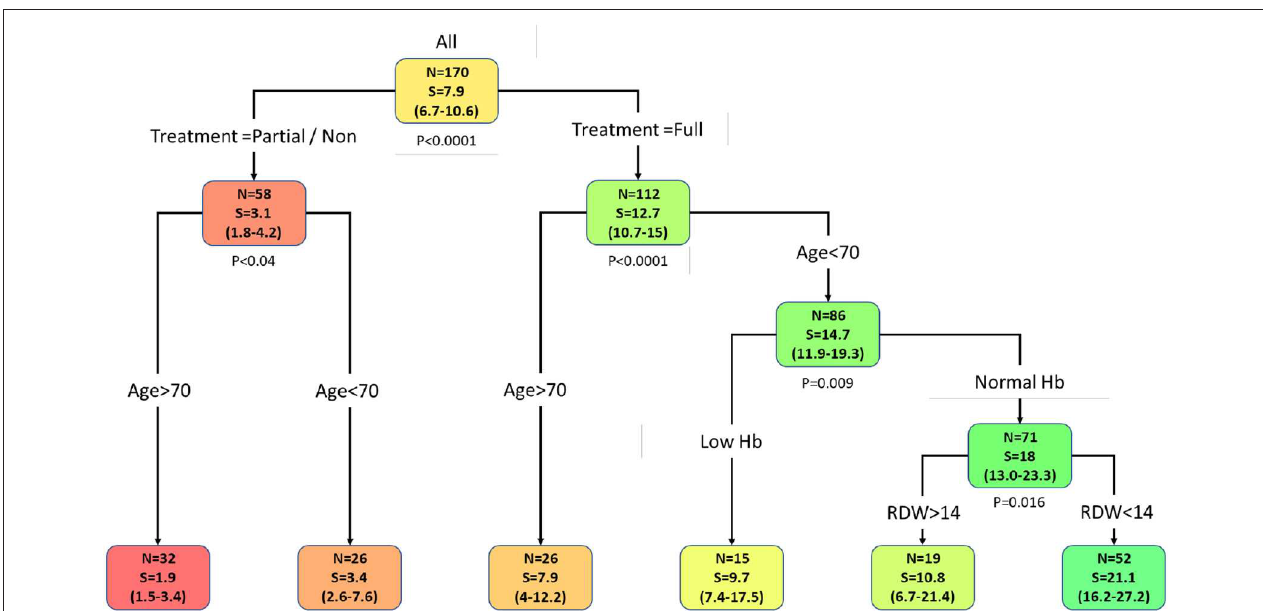
FIGURE 1 | Primary stratification tree which presents cohorts’ prognosis. Each colored box represents a specified subgroup with a number of patients ( N ), median overall survival in months (S), and 95% confidence interval (in brackets). The entire cohort was first divided into treated vs. partial/non-treated groups, which demonstrates a 4-fold increase in overall survival of the treated group compared to the partial/non-treated group. Notably, age under 70 is an independent favorable prognostic factor in both groups. Further stratification of treated patients whose age is under 70 revealed that normal hemoglobin level in those patients enhanced their overall survival to 18 months (95% CI 13–23.3) and RDW categorization to RDW < 14% highlighted a subgroup of 52 patients that survived for 21 months (95% CI 16.2–27.2). Hence, this cohort favorable prognosis group is characterized by the following four parameters: patients that underwent tumor resection supplemented with oncological treatment, age under 70, normal hemoglobin level, and RDW < 14%. Abbreviations: Hb, hemoglobin; RDW, red blood cell distribution